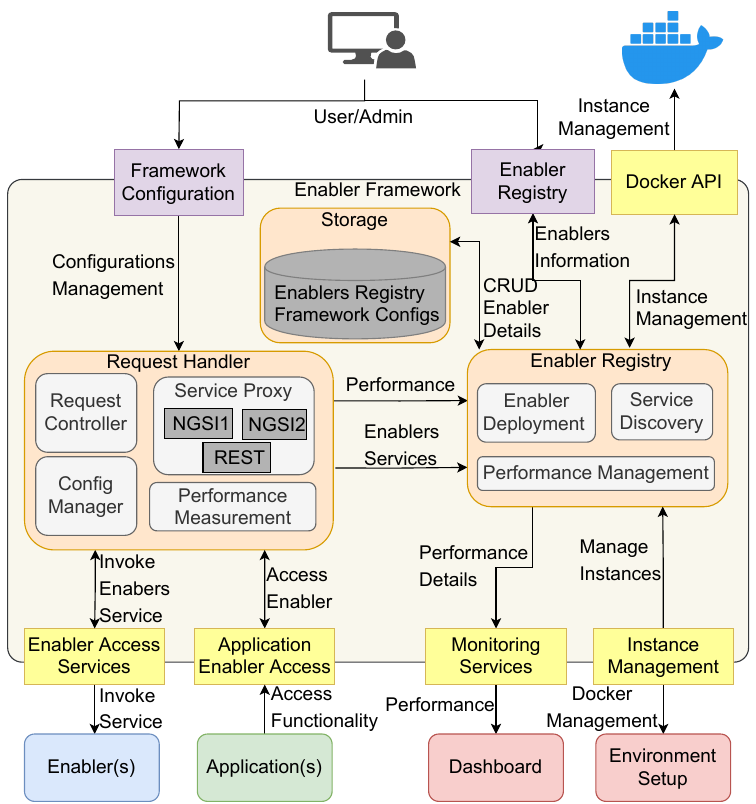
Figure 3. EF internal components and its interactions with external applications and